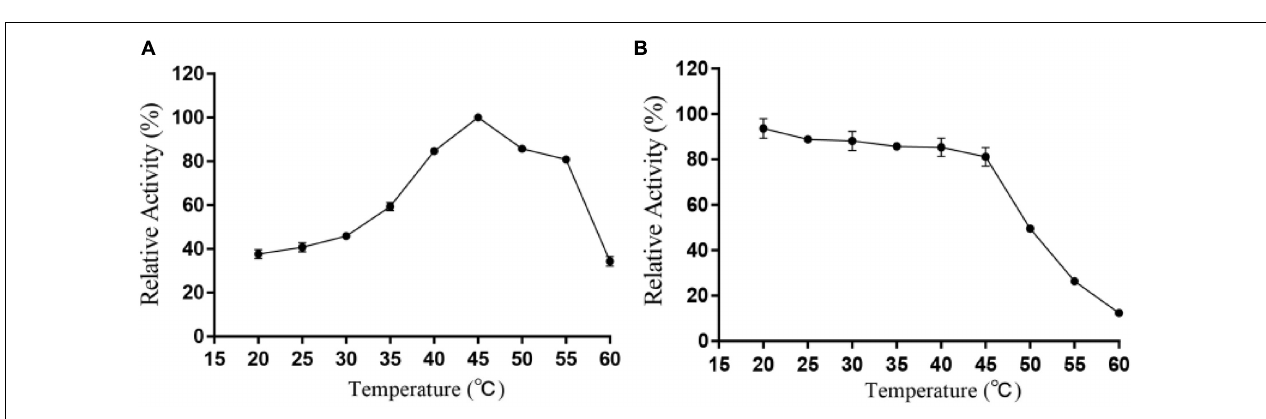
FIGURE 5 | Effects of temperature on the activity (A) and stability (B) of Alyw203. Values are expressed as mean ± SD, n =